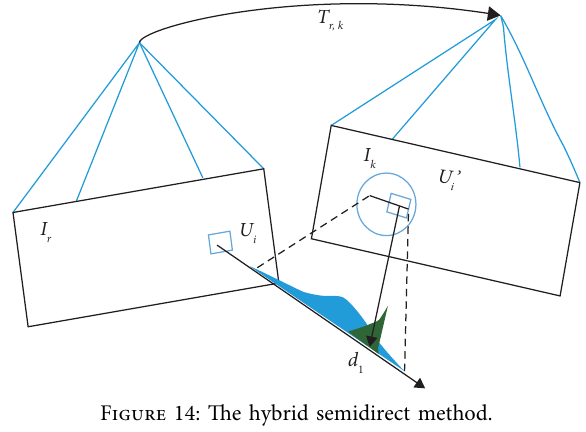
Figure 14: Te hybrid semidirect method.